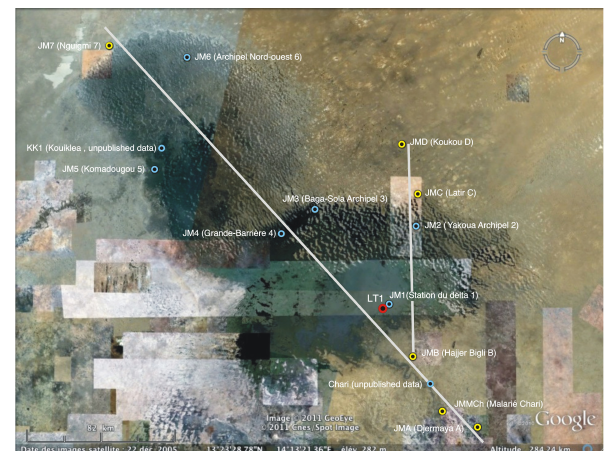
Fig. 2. Location of core LT1 (red circle; 13 ◦ 0 0 29 . 8 00 N, 14 ◦ 35 0 51 . 1 00 E) and modern pollen samples in Lake Chad and in the vicinity of the lake (blue circles are lacustrine or river sediment samples and yellow circles are surface soil samples). Images from Google Earth,